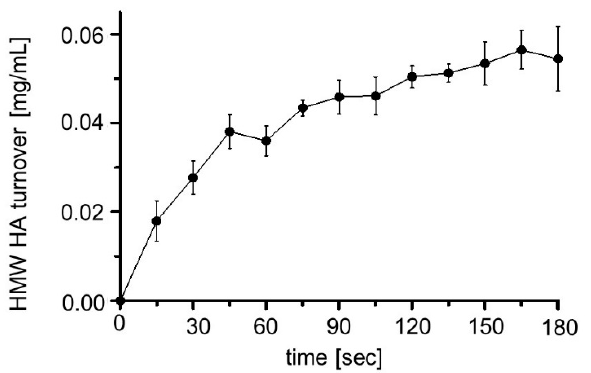
Figure 9. HMW turnover depending on the reaction time. E. coli F470 cells expressing Hyal1 were cultivated and after 16 h of induction the OD 578 was set to 10 by adding reaction buffer (sodium formate buffer (100 mM) pH 3.5, without NaCl). After adding 0.22 mg/mL HMW HA (1:1 v/v) reaction was performed at 37 °C for various times. The residual HMW HA was detected using the Stains-all assay. Mean values ± SD are given (n = 3).